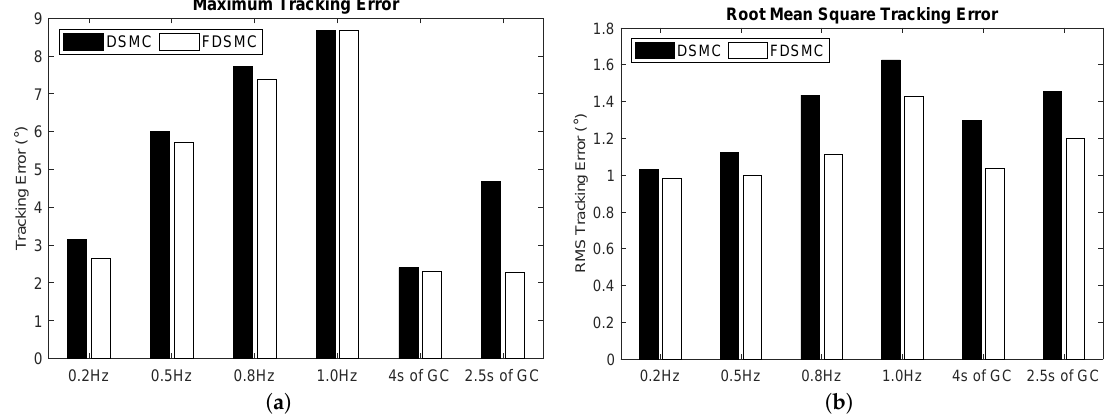
Figure 5. Experiment results of the proposed controller and conventional DSMC controller when tracking the human-gait pattern signal: ( a ) 4 s and ( b ) 2.5 s of gait cycle time. The experiment was carried out without a load.